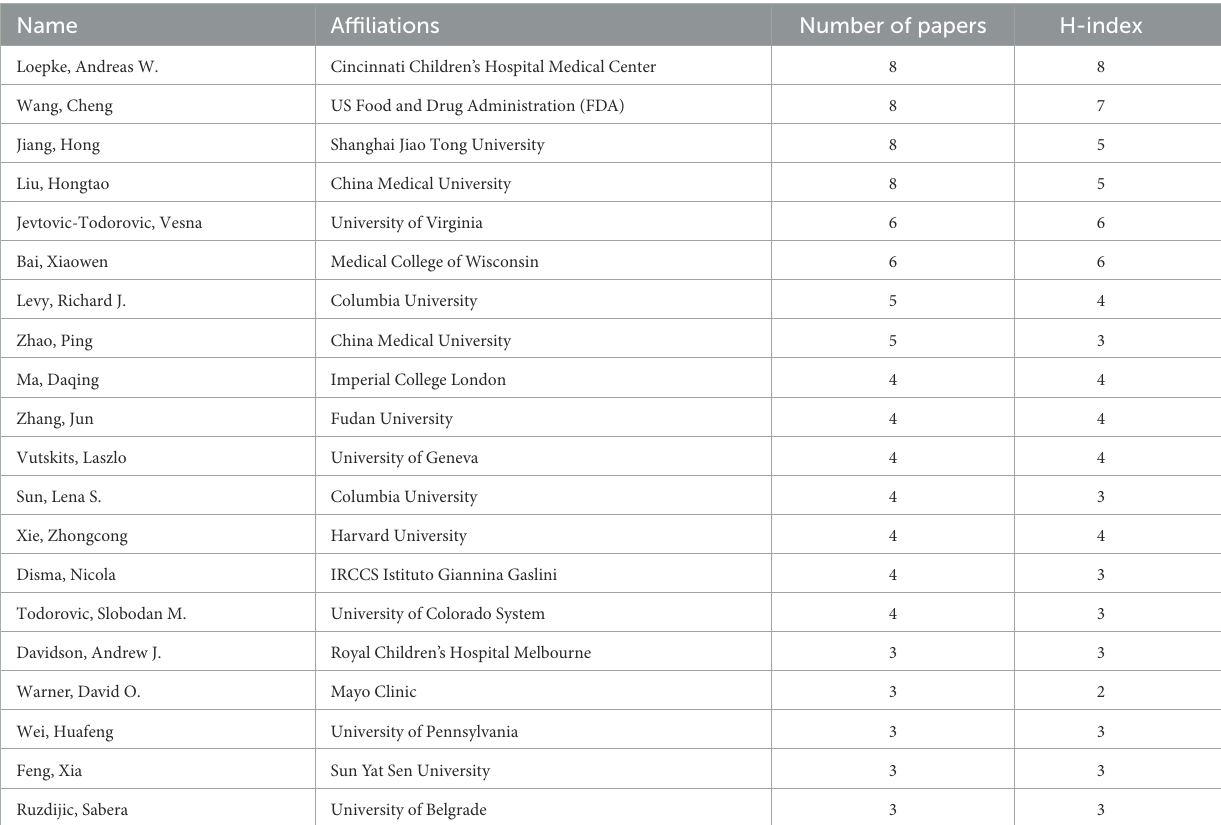
TABLE 2 The top 20 authors with the highest number of publications on the neurotoxicity of anesthesia in the developing